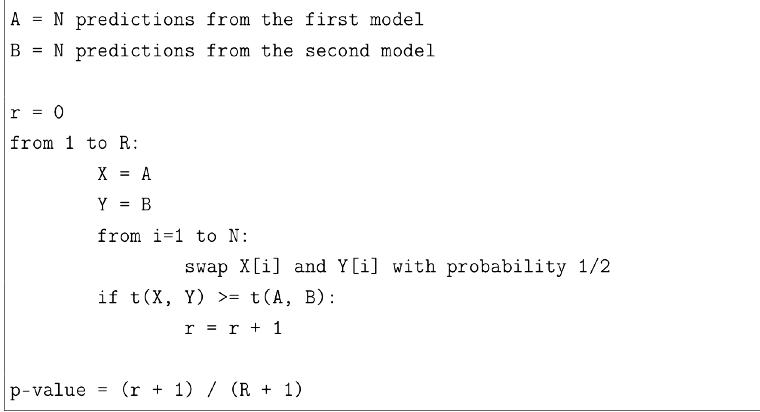
Figure 8. Pseudocode of the approximate randomization test. R is the number of repetitions selected. Adapted from [24].